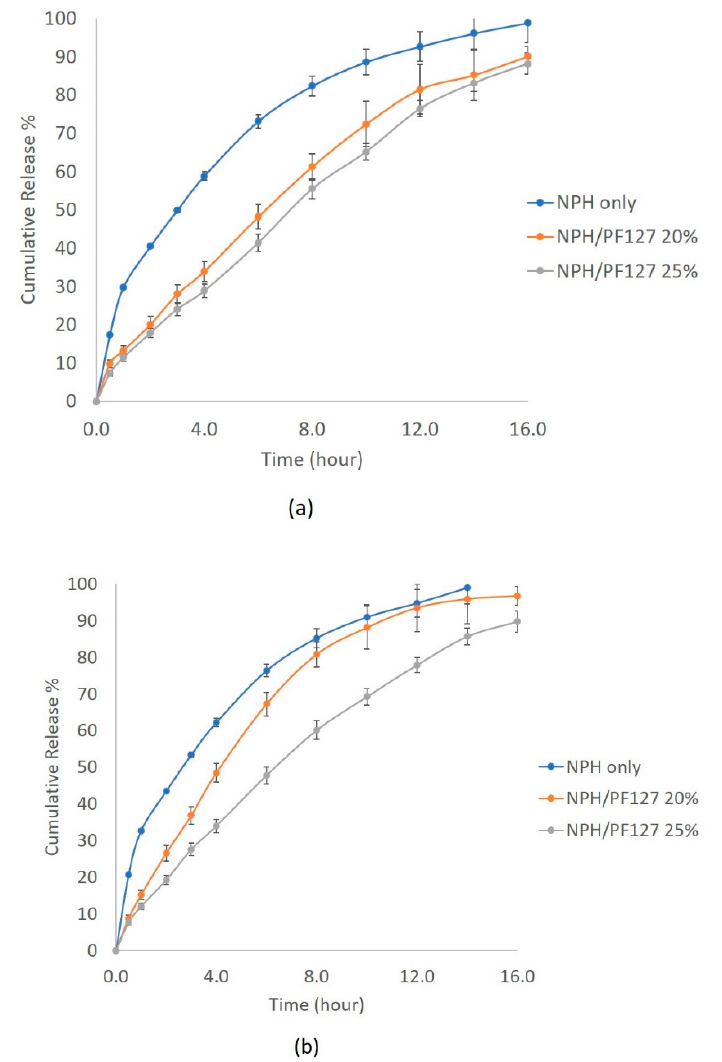
Figure 7. In vitro insulin release profile from NPH, NPH-PF127 (20%), and NPH-PF127 (25%) using PBS (pH 7.4) with trypsin concentrations of ( a ) 1 U / mL and ( b ) 5 U / mL.